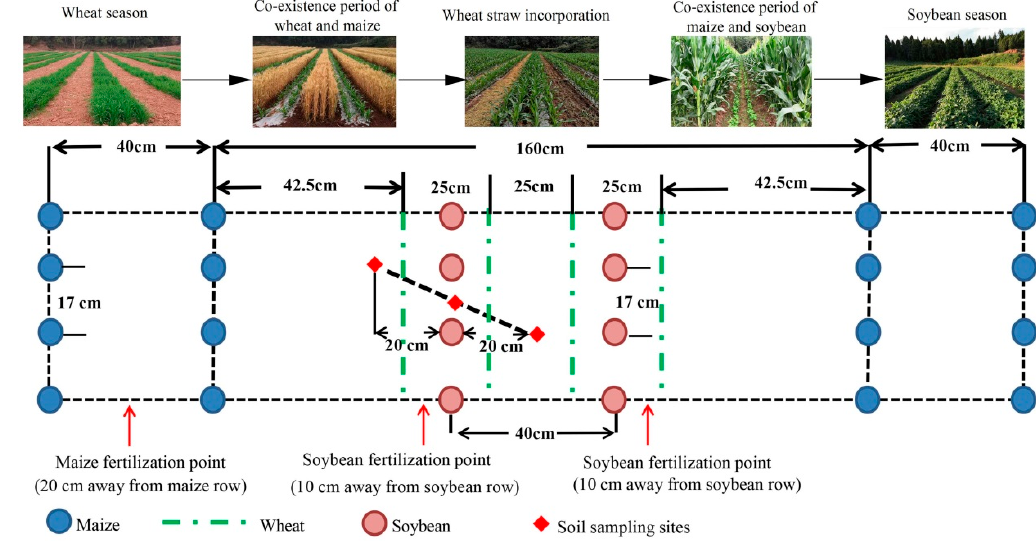
Figure 2. Schematic diagram of planting pattern.